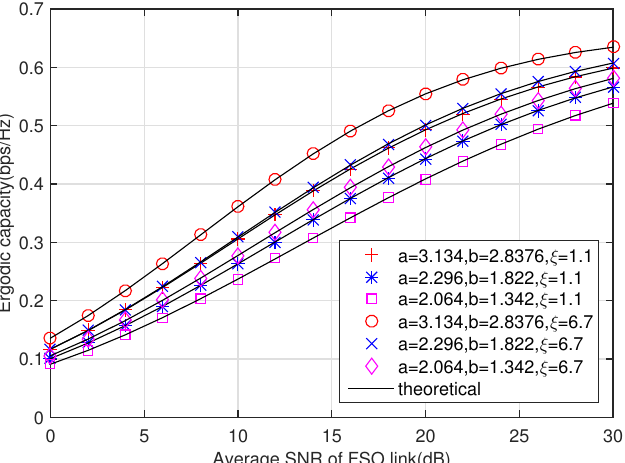
Figure 6. Ergodic capacity under different turbulence and pointing error conditions with IM/DD